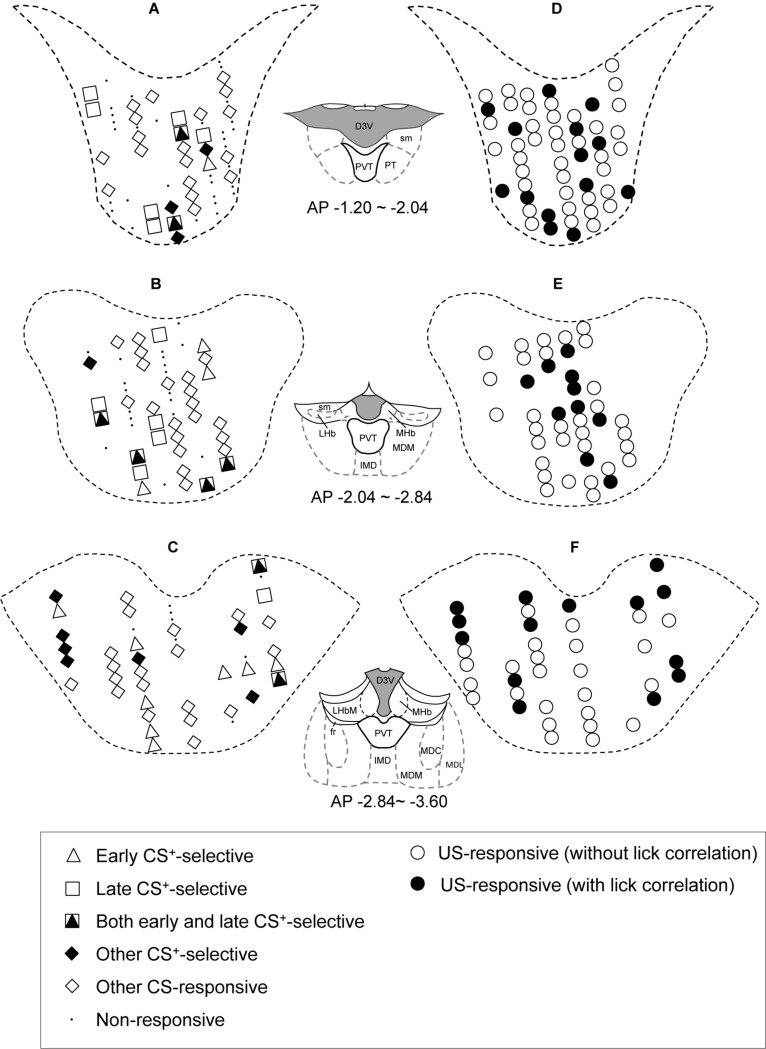
Recording sites of the PVT neurons. (A–C) Distributions of CS-responsive neurons. (D–F) Distributions of US-responsive neurons. PVT neurons are plotted on coronal sections. AP (anterior-posterior) number in each section indicates the distance (mm) posterior from the bregma. Other CS-responsive, other differential CS-responsive neurons plus non-differential CS-responsive neurons in Table 2. D3V, dorsal 3rd ventricle; LHb, lateral habenular nucleus; sm, stria medullaris; PVT, paraventricular nucleus of the thalamus; PT, paratenial thalamic nucleus; MHb, medial habenular nucleus; MDM, mediodorsal nucleus of the thalamus, medial part; IMD, intermediodorsal nucleus of the thalamus; fr, fasciculus retroflexus; MDL, mediodorsal nucleus of the thalamus, lateral part; MDC, mediodorsal nucleus of the thalamus, central part.